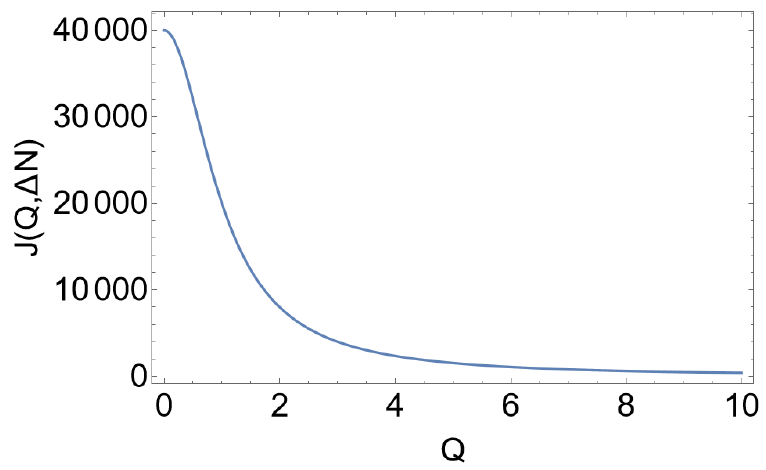
Figure 3 . The function J ( Q, ∆ N ) with N q − N IR = 10 4